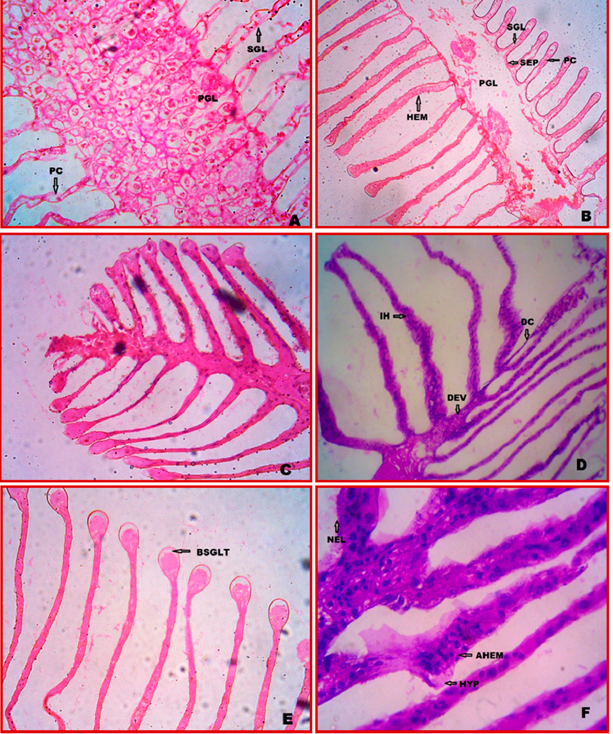
Figure 1. Gill cytopathological alterations in E. tetragonum : A paraffin slice stained with hematoxylin and eosin under the light microscope (40×), ( A , B ) — control ( C ) — after 7 days of exposure to chlorpyrifos at a dosage of 0.0294 ppm, ( D ) — after 28 days of exposure to chlorpyrifos at a dosage of 0.0294 ppm, ( E ) — after 7 days of exposure to 0.0588 ppm chlorpyrifos concentration, ( F ) — after 28 days of exposure to 0.0588 ppm chlorpyrifos concentration. Abbreviations used: SGL — secondary gill la- mellae, PCs — pillar cells, HEM — haemocytes, PGL — primary gill lamellae, SEP — septum, DC — de-